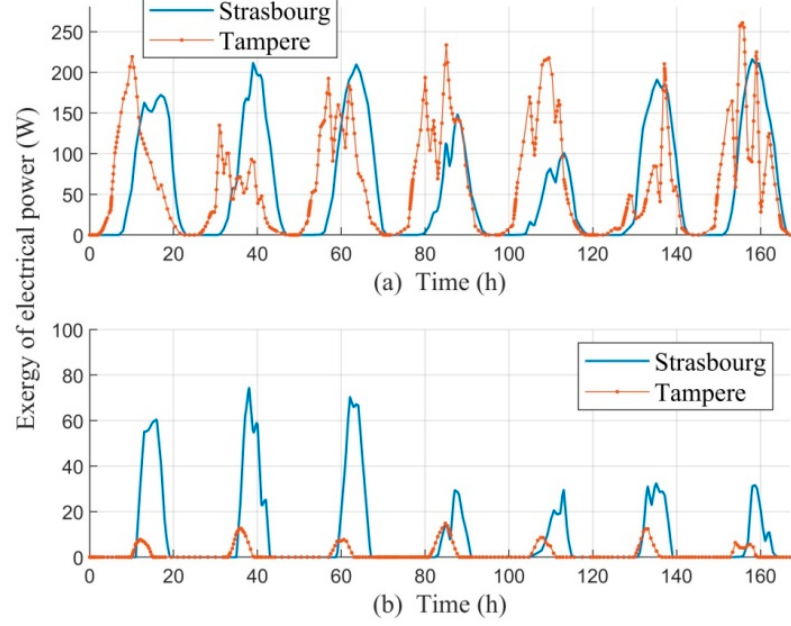
Figure 6. Exergy of electrical power during: ( a ) summer week; ( b ) winter week.